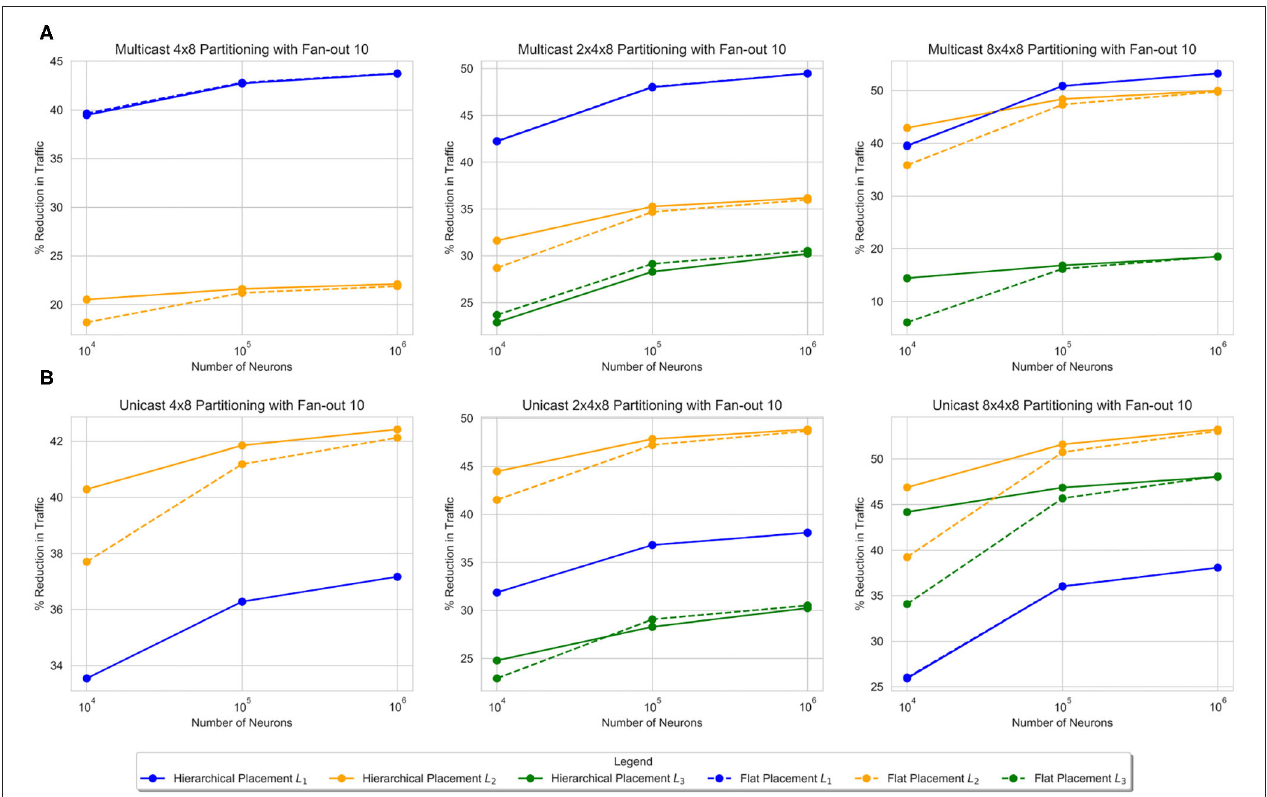
FIGURE 6 | Traffic reduction plots for small-world networks with different hierarchy structures and comparison of cost under multicast (A) and unicast (B) evaluation methods.